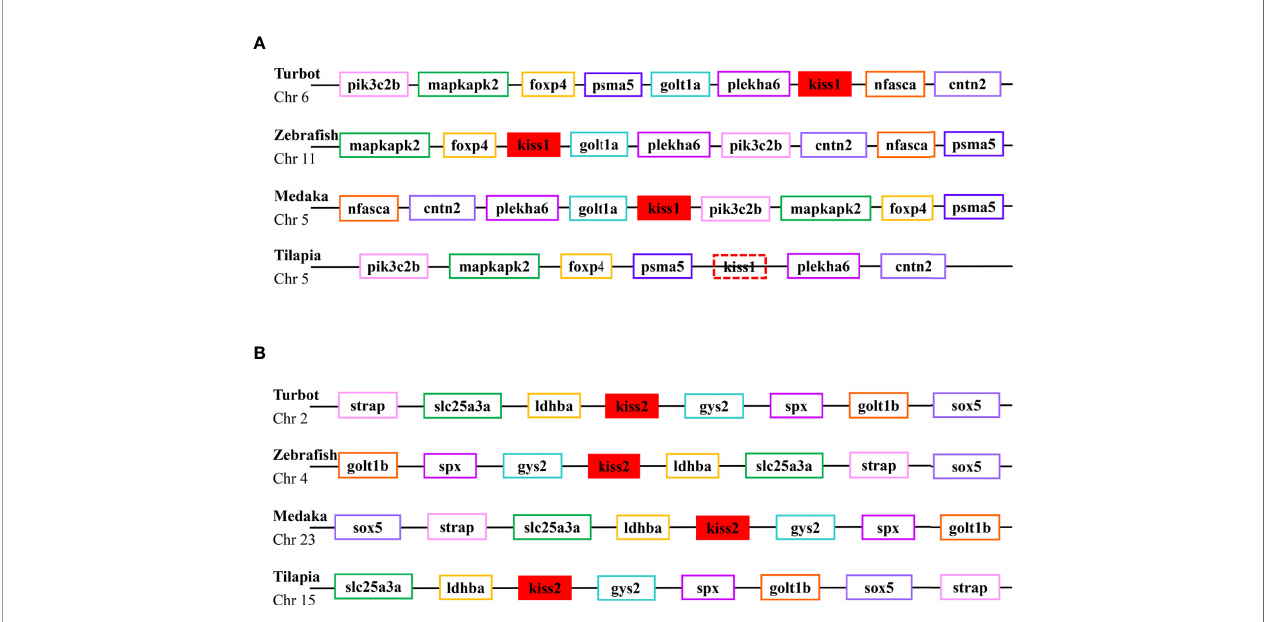
FIGURE 2 | Conserved synteny for the genomic region of kiss1 (A) and kiss2 (B) genes.